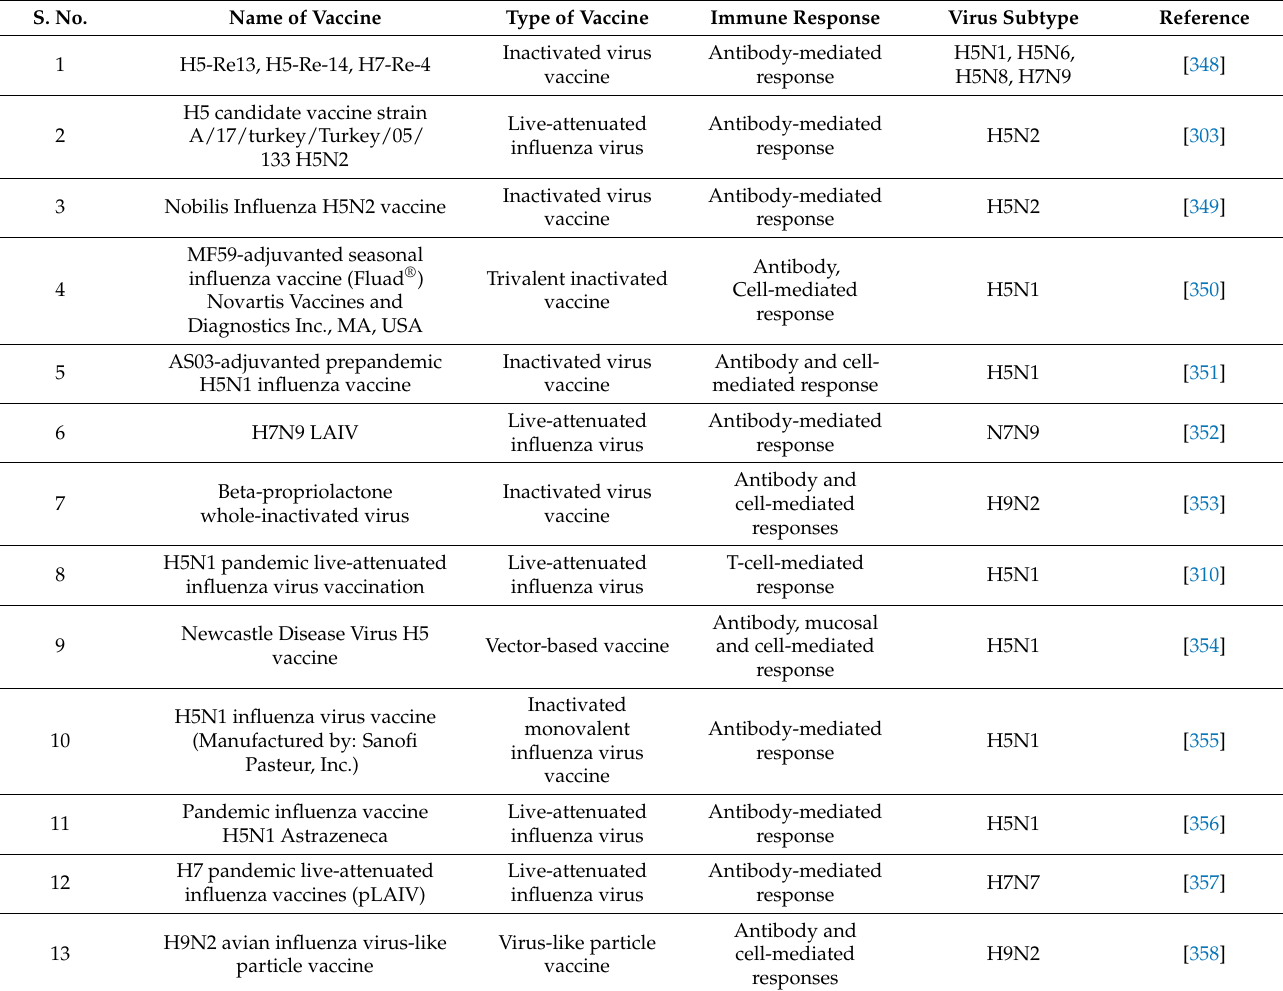
Table 3. Recent development of vaccines against avian influenza